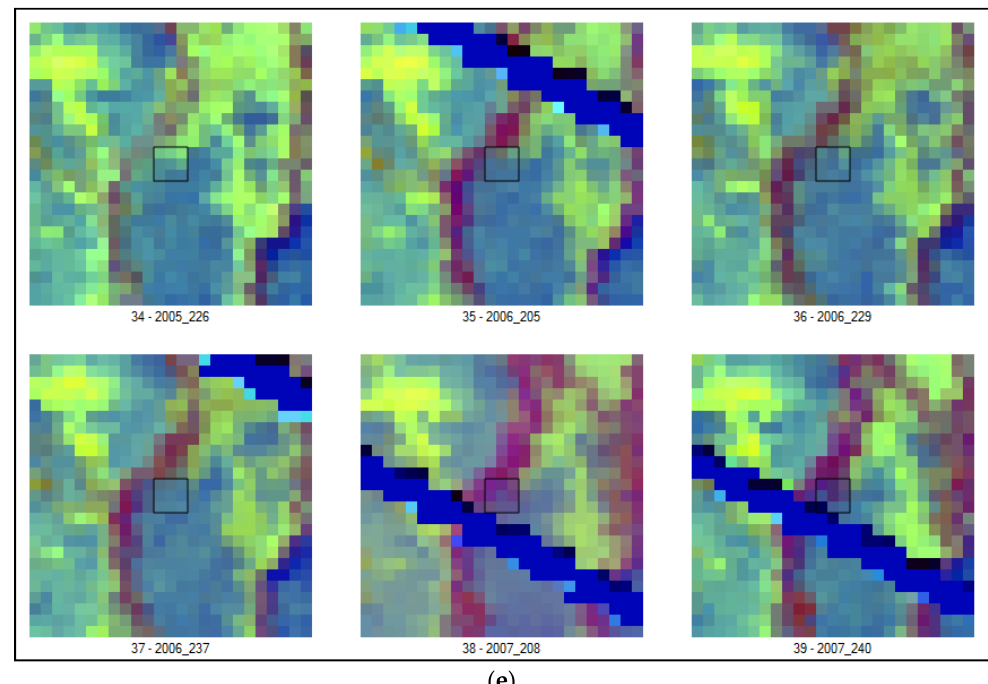
Figure A6. A 2007 Riparian patch generated by LandTrendr at Mount Rainier National Park. ( a ) Photo collected during field validation. Photo credit: NPS/ Natalya Antonova (2016). ( b ) Pre-disturbance 2006 aerial photo as viewed in Google Earth™. ( c ) Post-disturbance 2009 aerial photo as viewed in Google Earth™. ( d ) TimeSync spectral trajectory of nine pixels around patch centroid. ( e ) Part of the series of tasseled-cap image chips covering pre- and post-disturbance years as viewed in TimeSync. Dark blue streaks in ( e ) correspond to Landsat 7 missing scan lines.